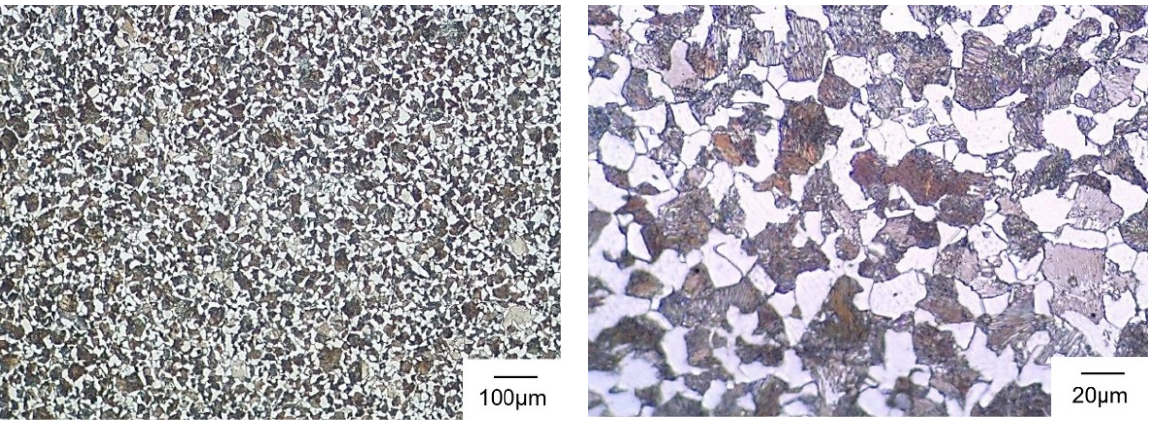
Figure 3. The LM images of microstructure of undeformed sample (transverse cross section) at different magnifications.